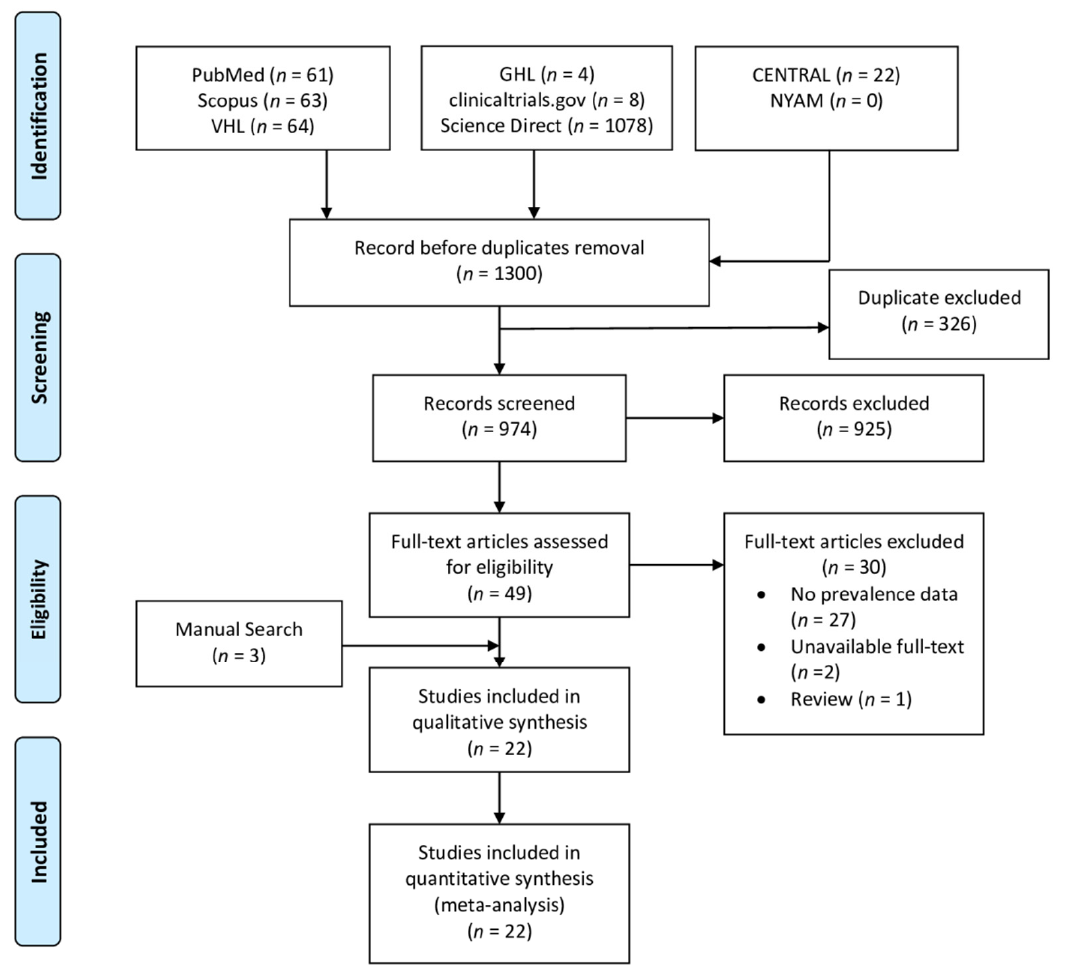
Figure 1. PRISMA diagram showing the screening process of our review. Table 1. Baseline characteristics of studies reporting equinus foot among patients with cerebral palsy ( n =